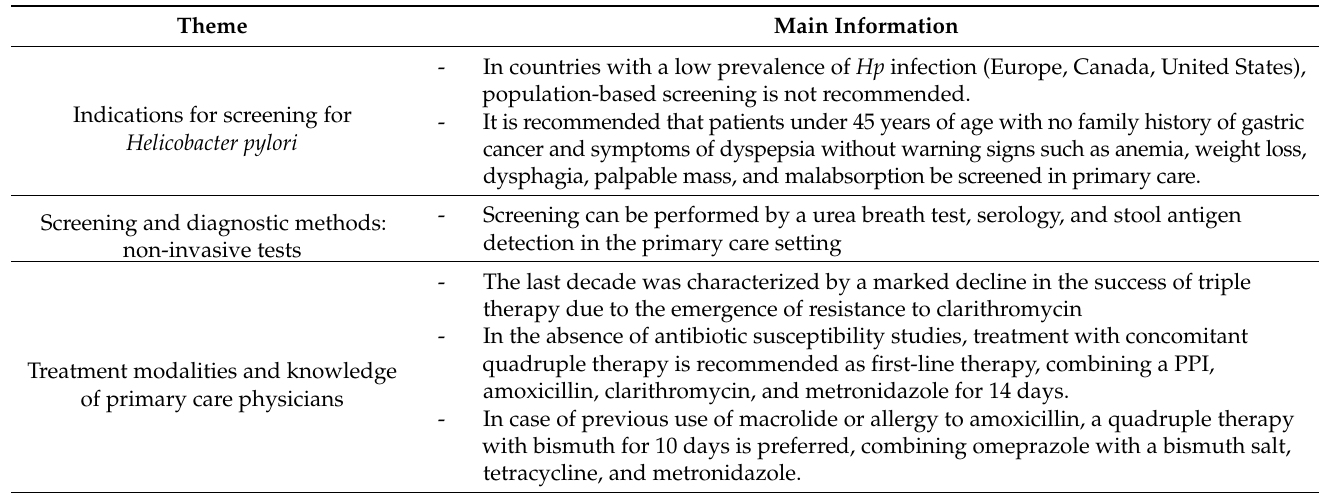
Table 1. Main information collected in the present review according to